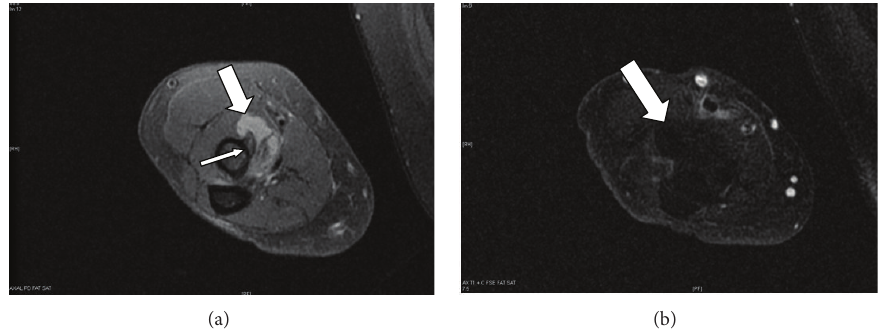
Figure 2: (a) MRI axial T1 weighted before IV gadolinium. Hyperintense signal showing the bursa (Fat arrow) and biceps tendon (thin arrow). (b) MRI axial T1 weighted after IV gadolinium sequences. Bursa (thick arrow).